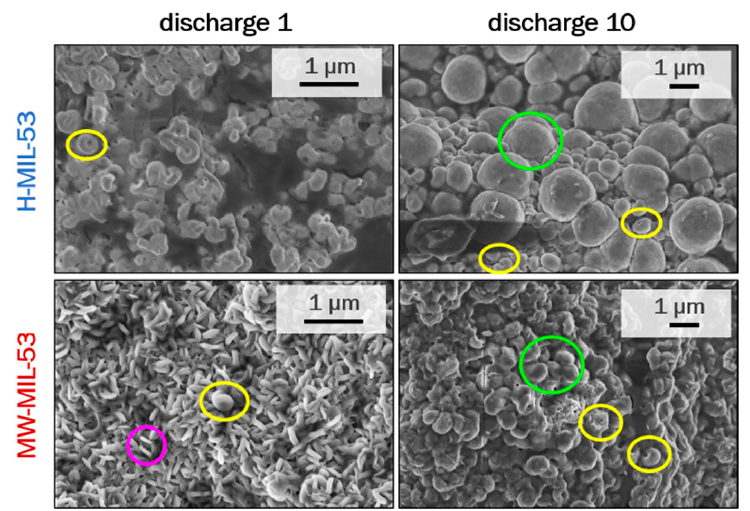
Figure 8. Ex situ XRD patterns (Mo-K α ) of the Super P carbon (green) and MIL-53 (blue) electrodes after 1 and 10 discharges, compared to a pristine electrode and a pristine electrode impregnated with 1M LiTFSI electrolyte. To visualize the evolution of the discharge product Li 2 O 2 , solid lines represent the Li 2 O 2 Bragg positions (101) and (110). The peak positions attributed to MIL-53 materials are drawn in pink dashed lines.